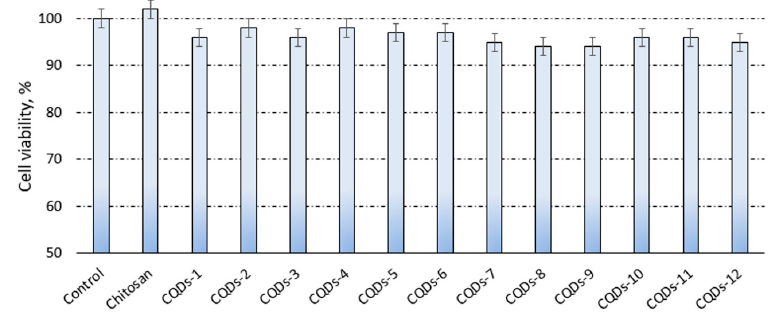
Figure 7. XTT assay study on human dermal fibroblasts.